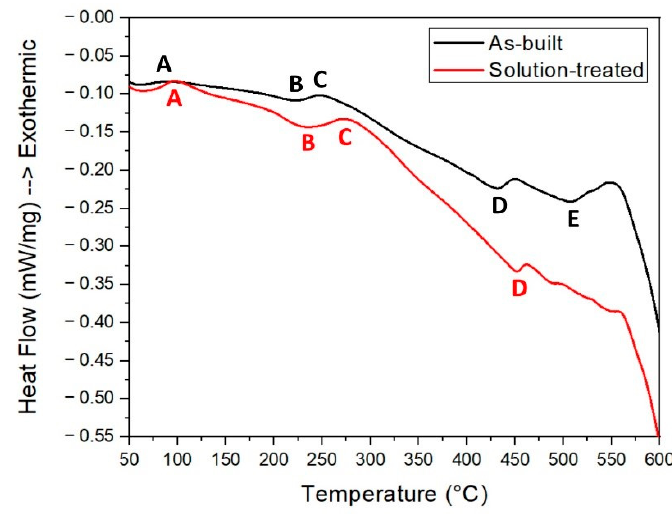
Figure 5. DSC curves of as-built and solution treated samples.